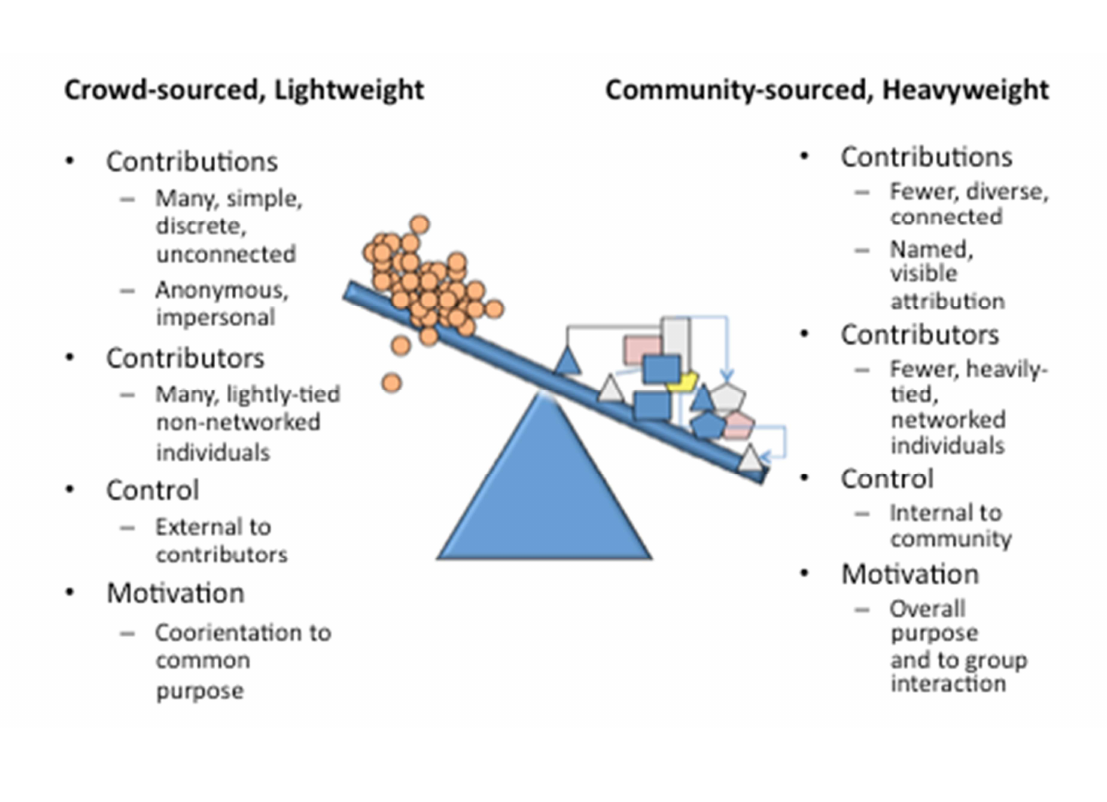
Figure 1: Lightweight to Heavyweight